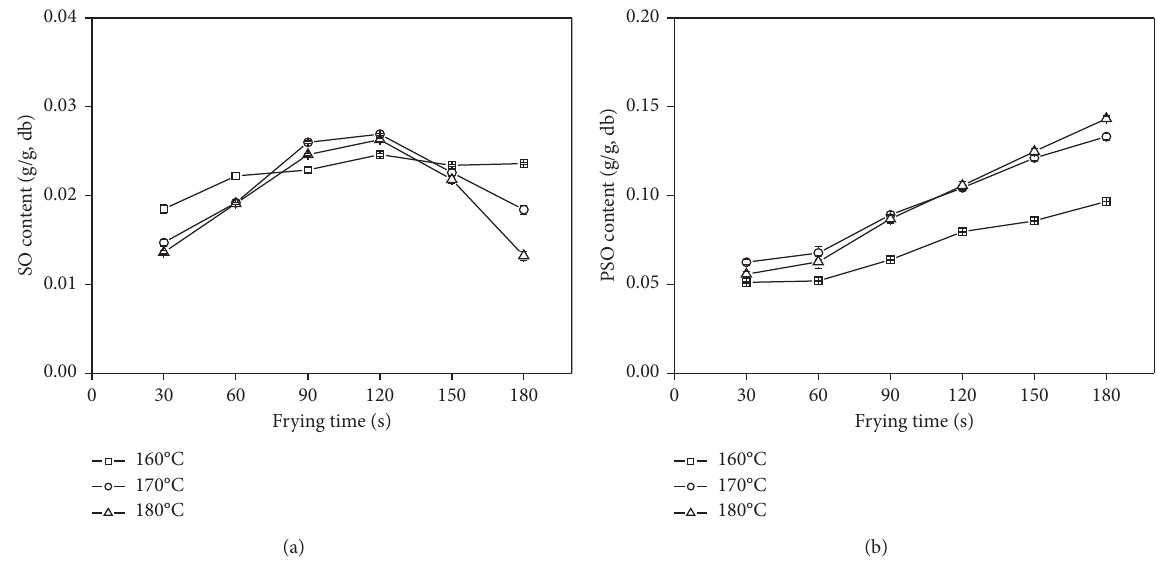
Figure 4: SO and PSO contents of BBFNs fried at different temperatures. (a) SO; (b)